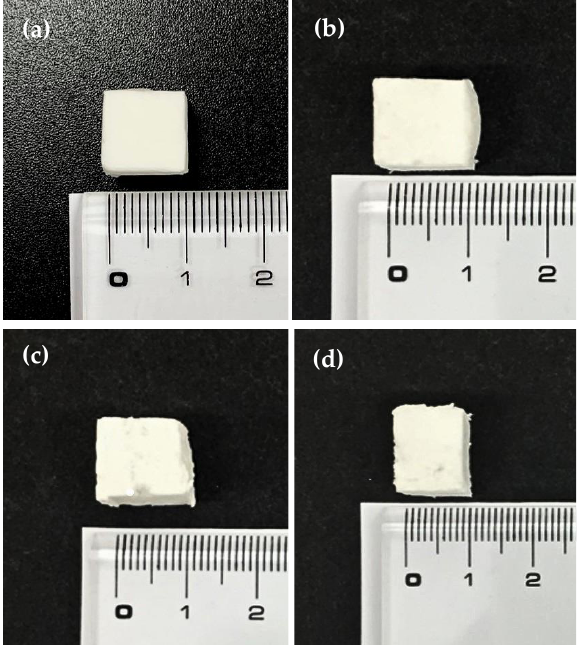
Figure 2. Photographs of ( a ) pure collagen scaffold, ( b ) collagen/β -TCP, ( c ) collagen/CS, and ( d ) collagen/β -TCP/CS composite scaffolds.